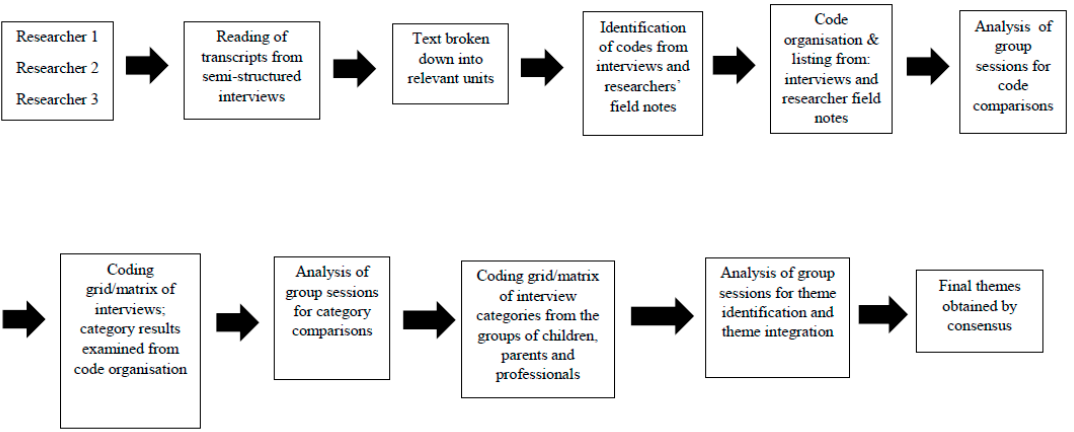
Figure 1. Thematic analysis process.